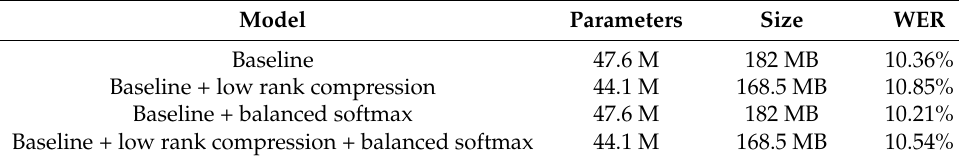
Table 8. Results of the ablation study of the proposed Conformer